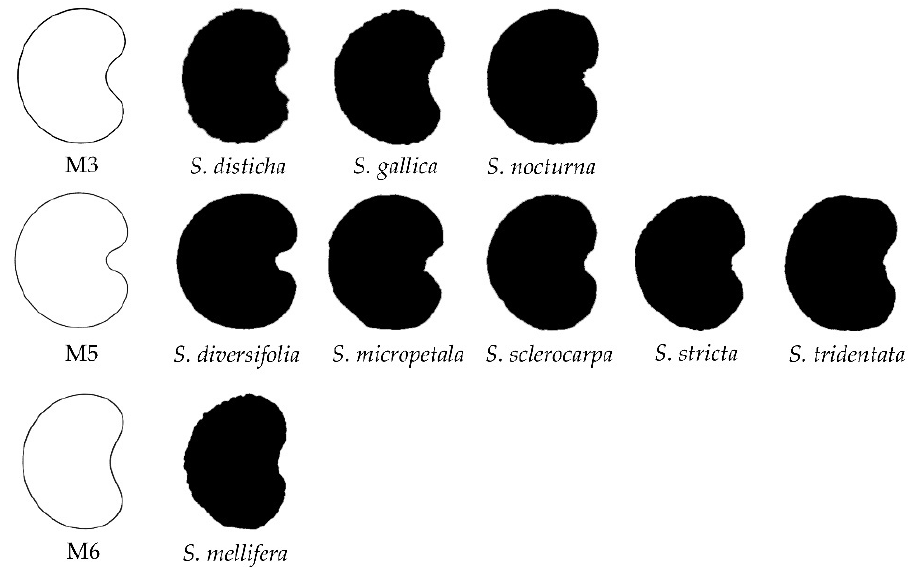
Figure 7. Models 3, 5, and 6 with the average silhouette of Silene species. Top row: Model 3, S . disticha , S . gallica and S . nocturna . Middle row: Model 5, S . diversifolia , S . sclerocarpa S . stricta , S . micropetala and S . tridentata ; Bottom row: Model 6, S . mellifera .